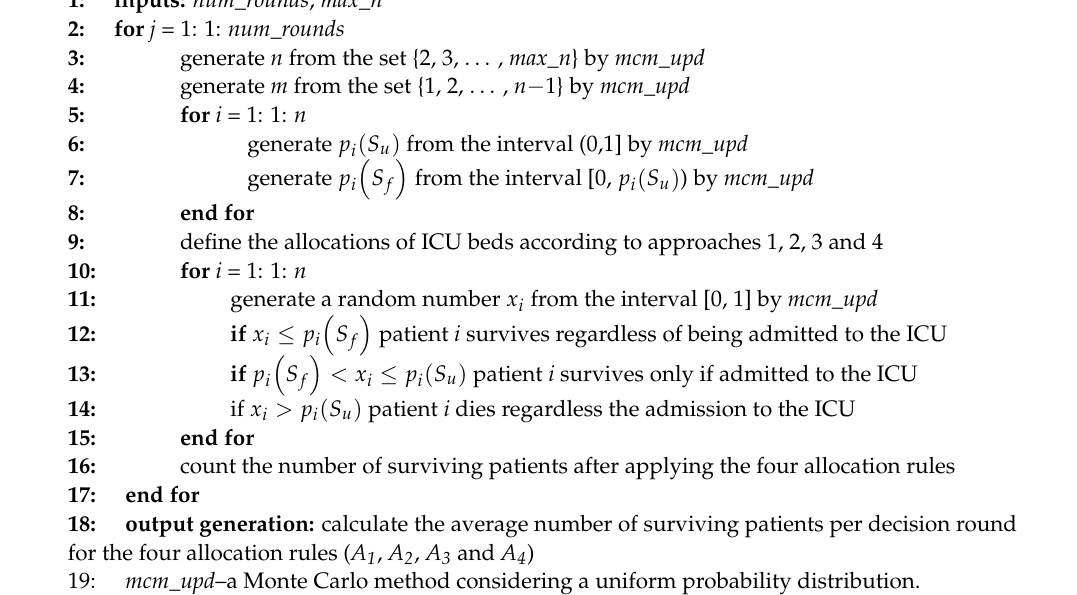
(cid:104) ( A 1 − A i ) A